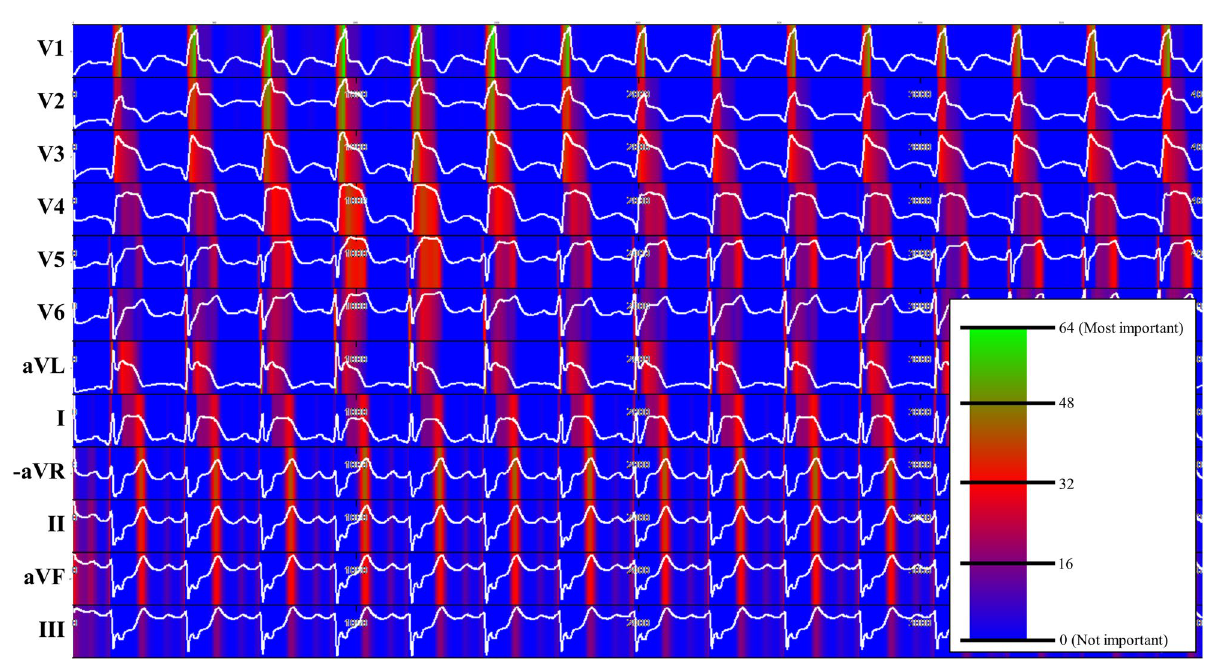
Figure 5. Sensitivity map of DLA for detecting MI. DLA deep learning-based algorithm, MI myocardial